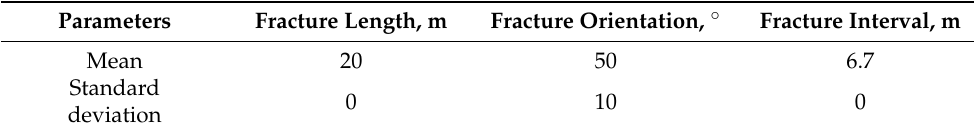
Table 2. Input parameters for natural fracture generation.